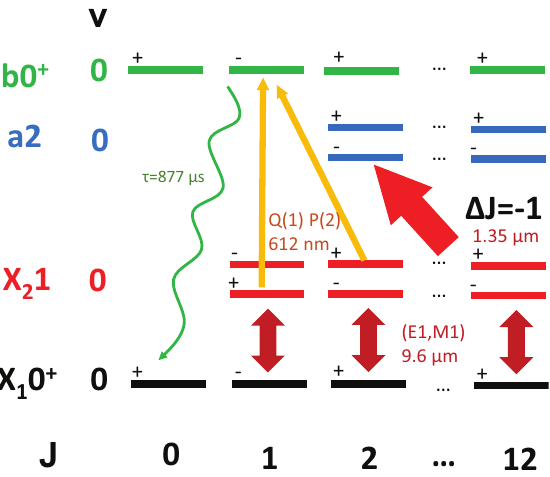
Figure 5. Rotational cooling scheme using X → a2 at 1300 nm. Straight arrows show transitions driven by lasers, with arrow width indicating laser linewidth. Yellow arrows indicate CW-assist lasers. The wavy arrow indicates the spontaneous emission channel to the dark